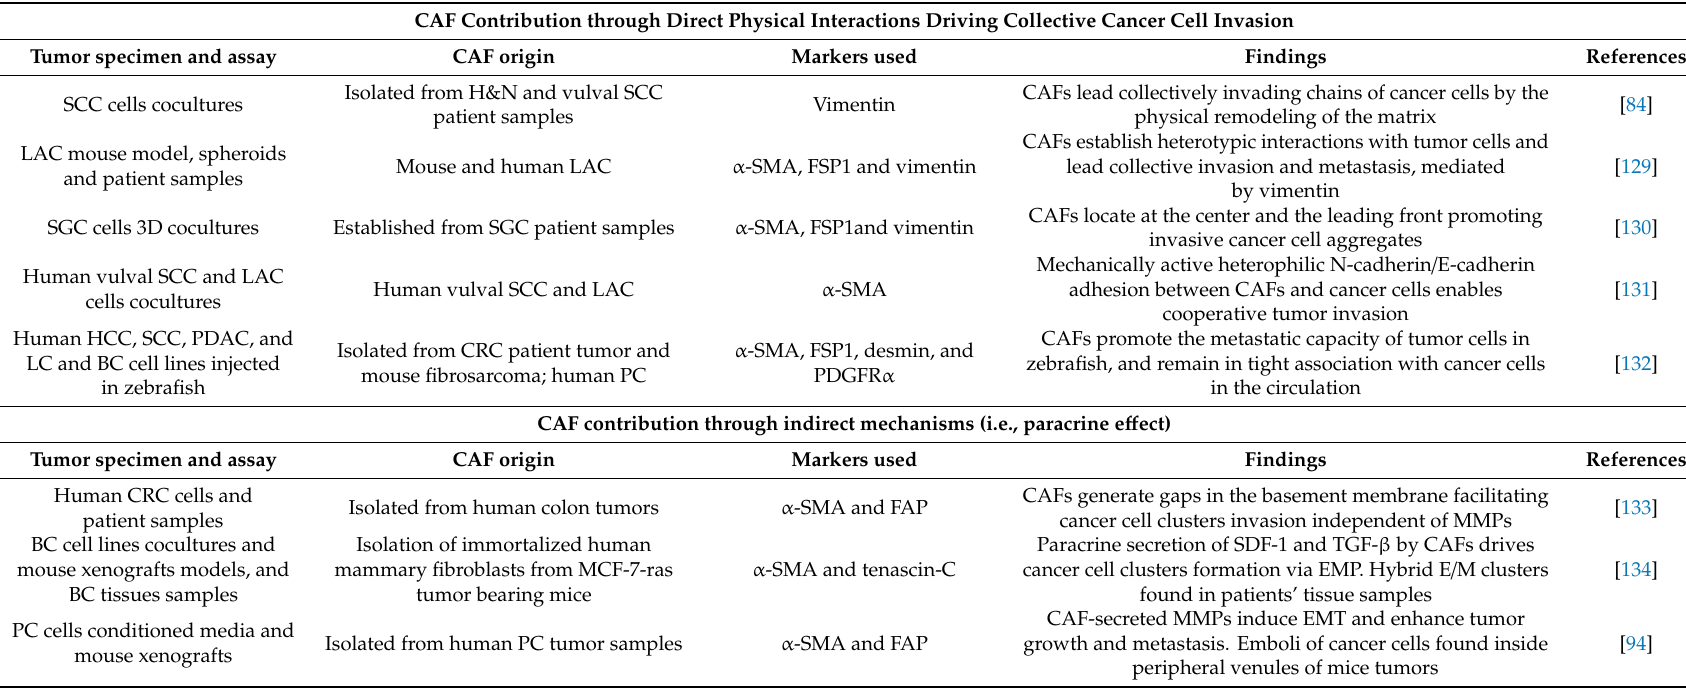
Table 1. Direct or indirect evidence of the contribution of CAFs to CTC cluster formation or CTC cluster metastatic